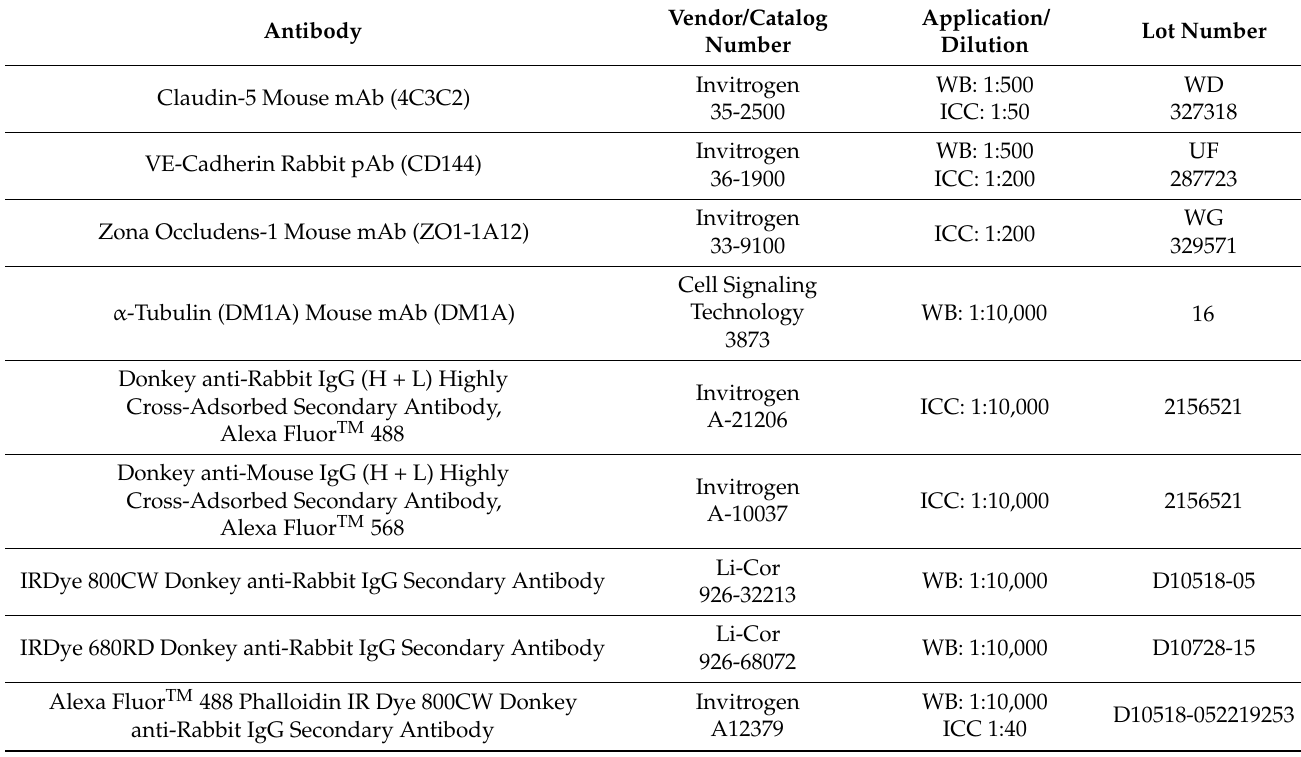
Table 1. Table of antibodies, vendor catalog number, dilution factor by application, and lot number.